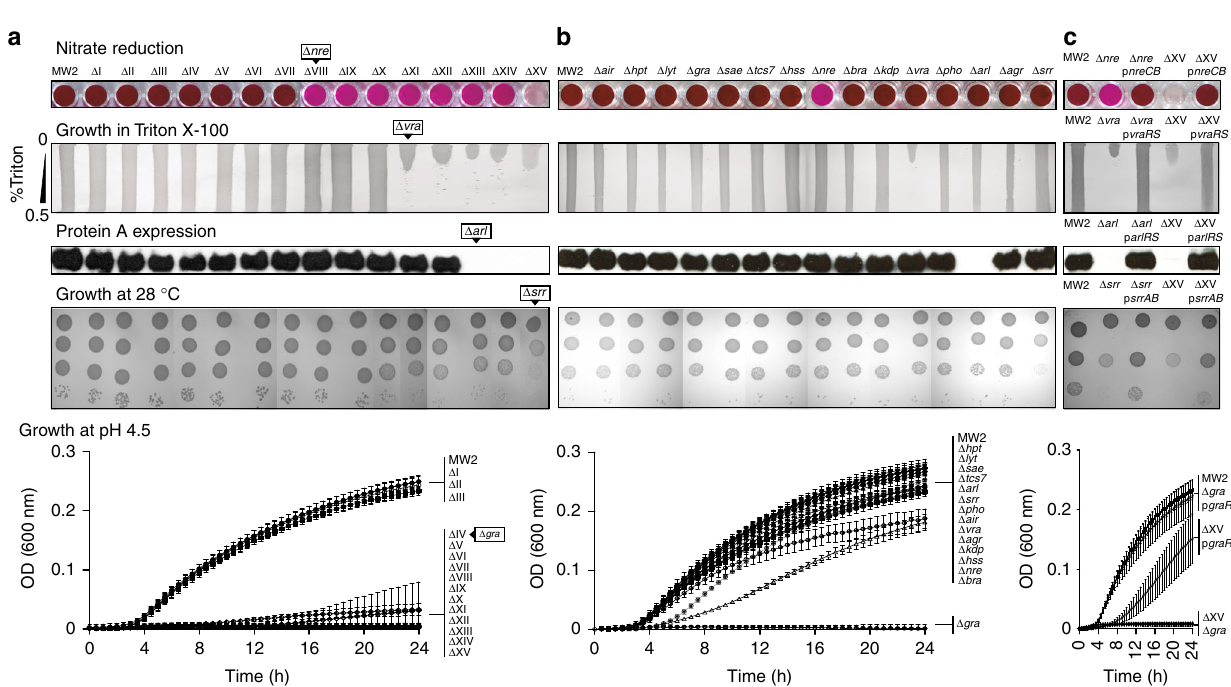
Fig. 3 Genome-wide evaluation of modularity and self-suf fi ciency of TCSs in S. aureus . a Phenotypes of sequential TCS mutants: (i) nitrate reduction capacity, nitrite presence was colorimetrically detected; (ii) growth capacity on Triton X-100 concentration gradient agar plates; (iii) protein A expression in CDM detected by western blotting (full blots are shown in Supplementary Fig. 9); (iv) growth ability on TSA medium at 28 °C, serial dilutions were spotted on agar plates; (v) growth curves in TSB medium at pH 4.5, average and SD of three independent assays were recorded. TCSs whose mutation induces a phenotypic change are indicated. b Phenotypes of individual TCS mutants. Experimental conditions are described in a . c Phenotypes of selected individual and Δ XV mutant strains complemented with the corresponding TCS. Experimental conditions are described in